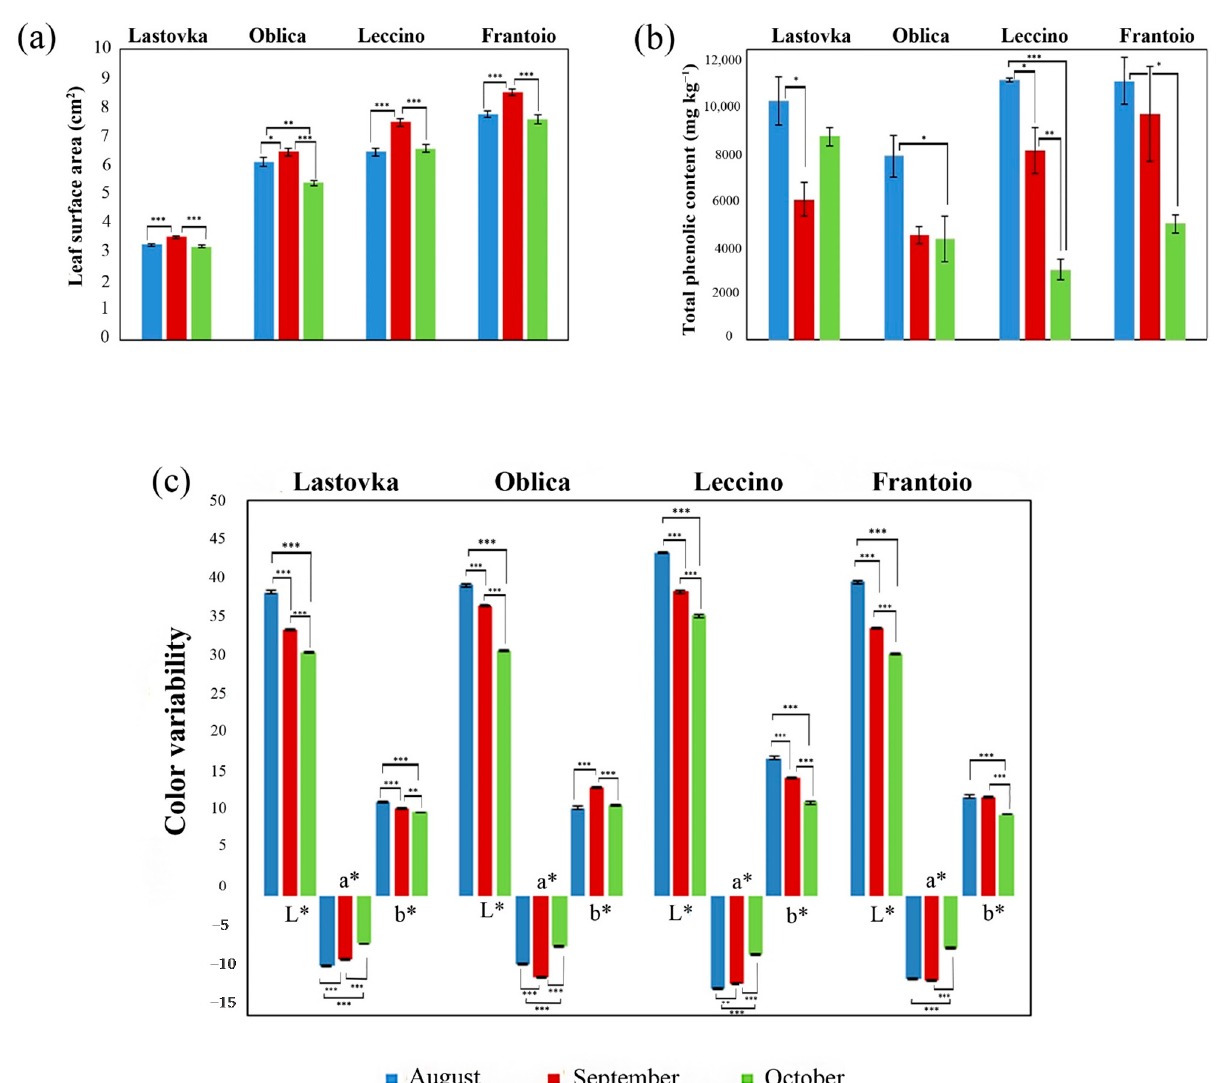
Figure 1. Graphical representation of the values obtained for surface area, total phenolic amount and color variability of leaves from cvs. Lastovka, Oblica, Leccino and Frantoio at different harvest periods. Statistically significant test result is considered for p ≤ 0.05. * p ≤ 0.05; ** p ≤ 0.01; *** p ≤ 0.001. ( a ) Difference in leaf surface area from cvs. Lastovka, Oblica, Leccino and Frantoio at 22 August, 12 September, and 25 October ( b ) Difference in total phenolic content from cvs. Lastovka, Oblica, Leccino and Frantoio at 22 August, 12 September, and 25 October ( c ) Difference in color variability from cvs. Lastovka, Oblica, Leccino and Frantoio at 22 August, 12 September, and 25 October.